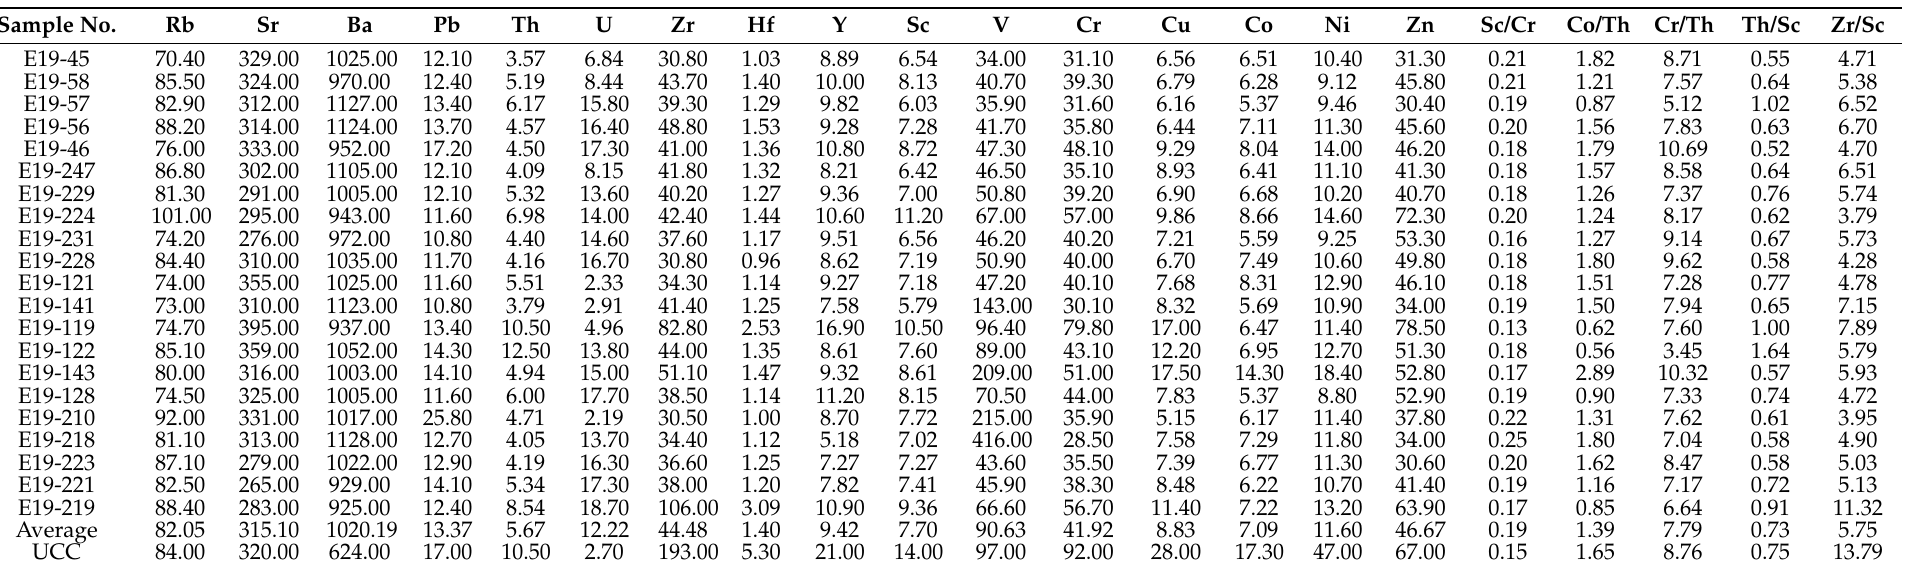
Table 2. Trace element concentrations (ppm) of sandstones from the Zhiluo